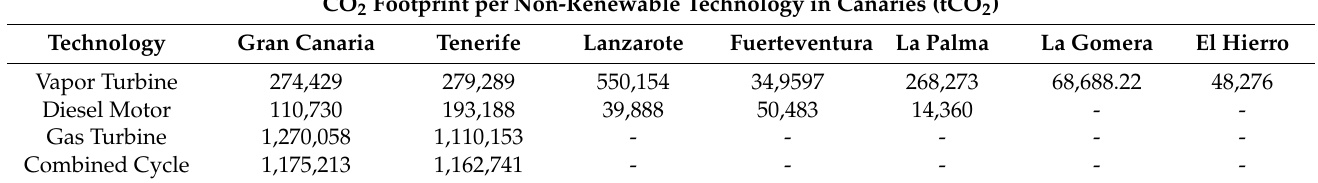
Table 8. Carbon footprint according to the technological structure of the generation parks that uses oil products in the Canary Islands, broken down by islands (2017) [15].